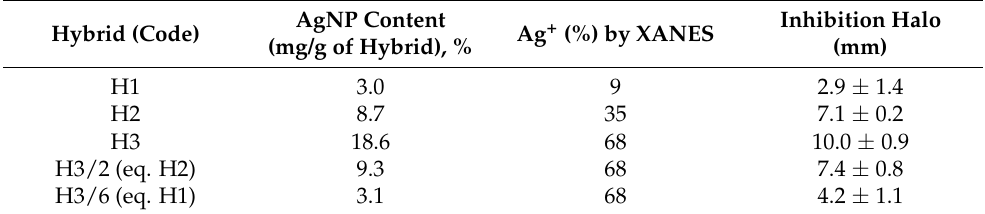
Figure 3. ( a ) Variation of the inhibition halo diameter and of the Ag + ion concentration released in water measured by conductimetry as a function of the AgNP content in the CNC/AgNP hybrid suspensions. All AgNPs have an average diameter of ~10 nm. ( b ) Comparison between inhibition halos of CNC/AgNP at different AgNP contents with and without H 2 O 2 redox post-treatment. Inset: Evolution of Ag + release in water at 48 h measured by conductimetry. Table 3. Characteristics of hybrid samples used in biocidal tests to discriminate the antibacterial activity of Ag + and Ag + fractions in